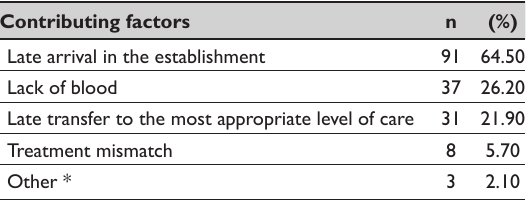
Table 5: Contributing factors to the occurrence of maternal deaths in Dori Hospital, Burkina Faso, 2014 –